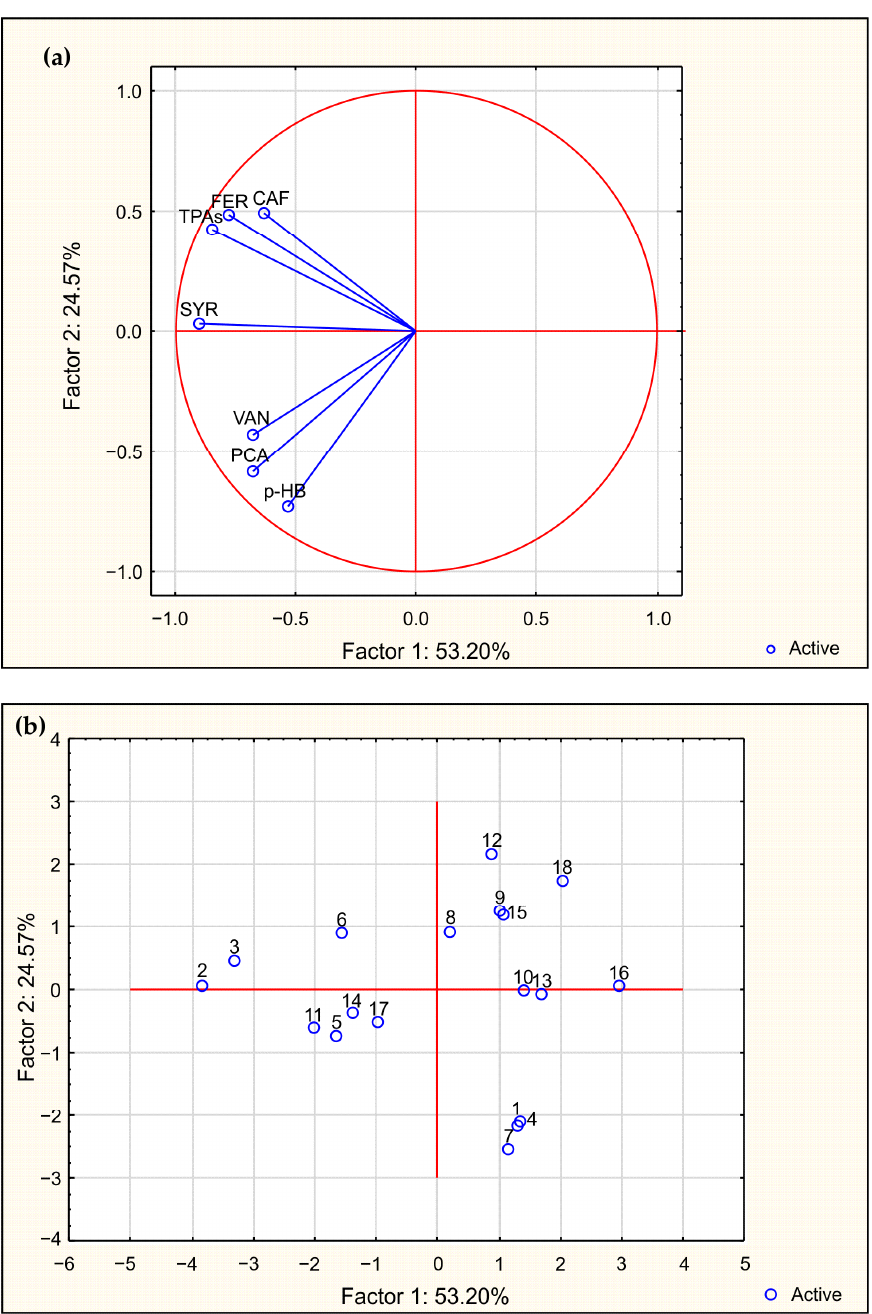
Figure 5. Principal components analysis of the ( a ) distribution of the analyzed parameters, and ( b ) distribution of variants of the experiment: 1—Dukla/EKO/Batuta; 2—Dukla/EKO/Hybred; 3— Dukla/EKO/Hymack; 4—Dukla/INT/Batuta; 5—Dukla/INT/Hybred; 6—Dukla/INT/Hymack; 7— Dukla/CON/Batuta;